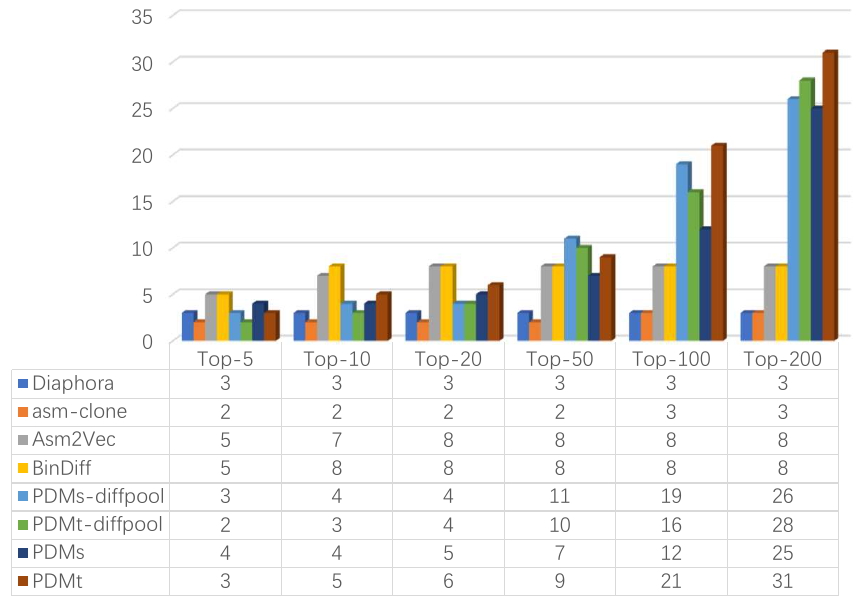
Figure 9. Vulnerability ranking compared with state-of-the-art